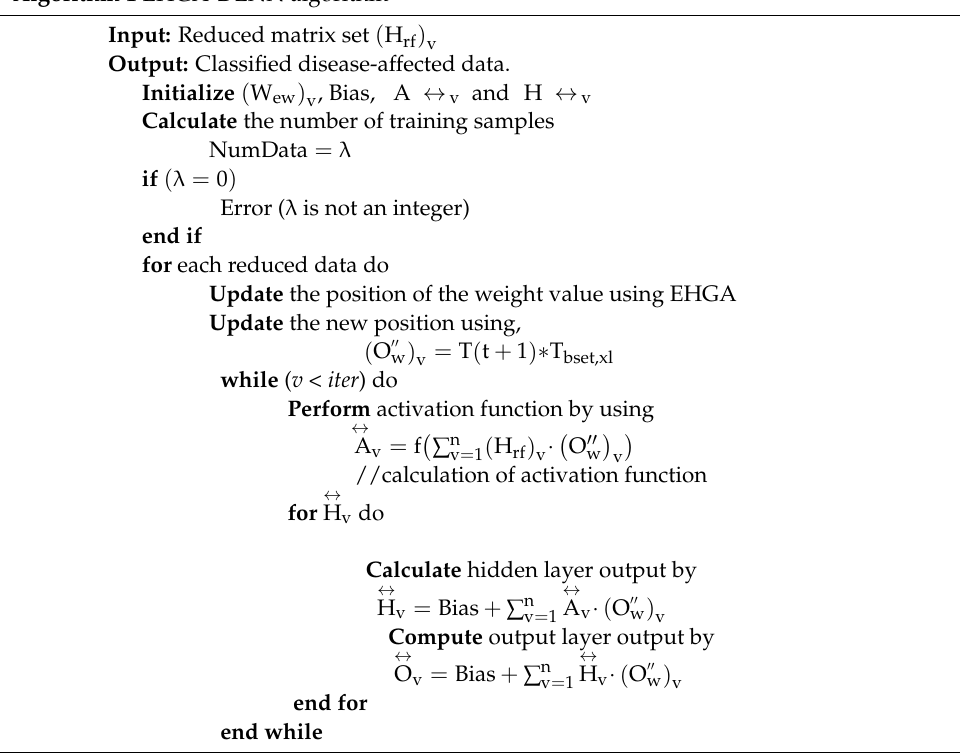
Algorithm 1 EHGA-DLNN